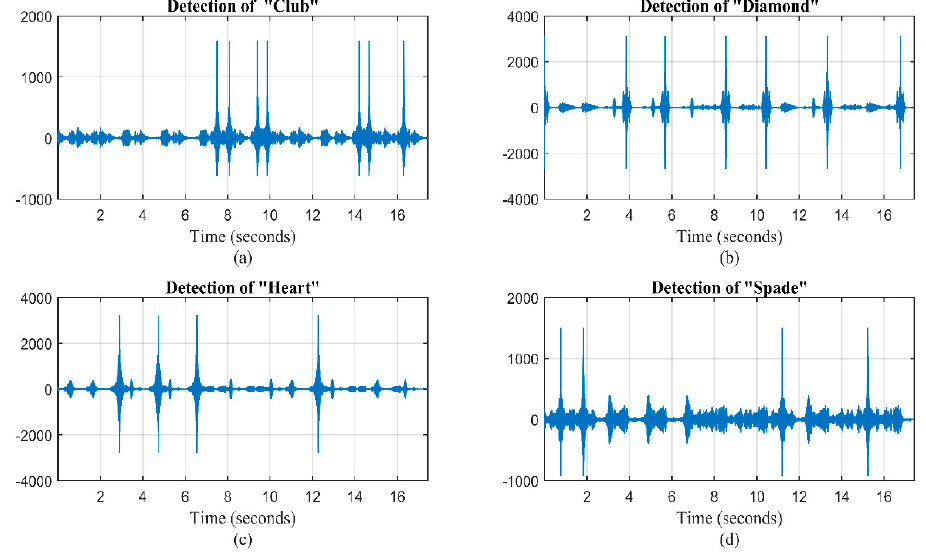
Figure 10. Detection of bionic Morse elements ( a ) club, ( b ) diamond, ( c ) heart and ( d ) spade from a mimicked message